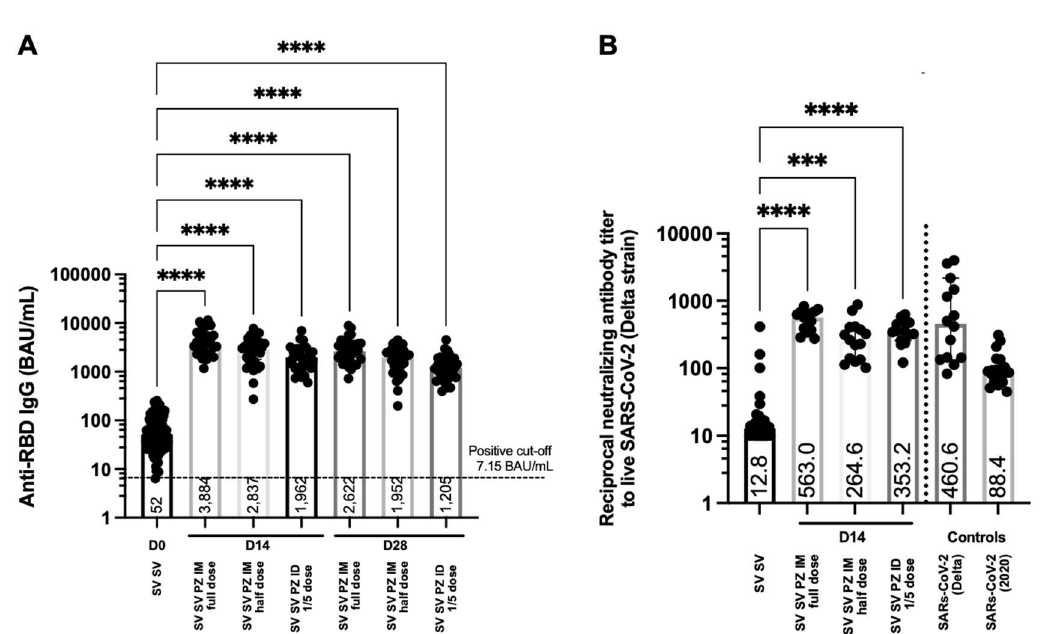
Figure 4. Antibody responses and neutralising function after boosting. Participants who had received two doses of inactivated SARS-CoV-2 vaccines were recruited in this study (SV SV). Conventional (full dose) and fractional dose (half dose) of the mRNA vaccine were administered intramuscularly (SV SV PZ IM). The fractional dose (1:5 dose) of the mRNA boost was delivered intradermally (SV SV PZ ID). Blood was collected pre (D0) and post boosting 14, 28 days (D14, D28). ( A ) Serum samples were analysed using CMIA to measure anti-RBD IgG. ( B ) Neutralising antibodies against the Delta variant was tested using PRNT. Convalescent sera were included as controls. Each symbol represents one participant, and the number is the median of each group ( n = 30–31 volunteers). Statistical significance was determined using the Kruskal–Wallis test, with Dunn’s multiple comparisons test. *** p ≤ 0.001; **** p ≤